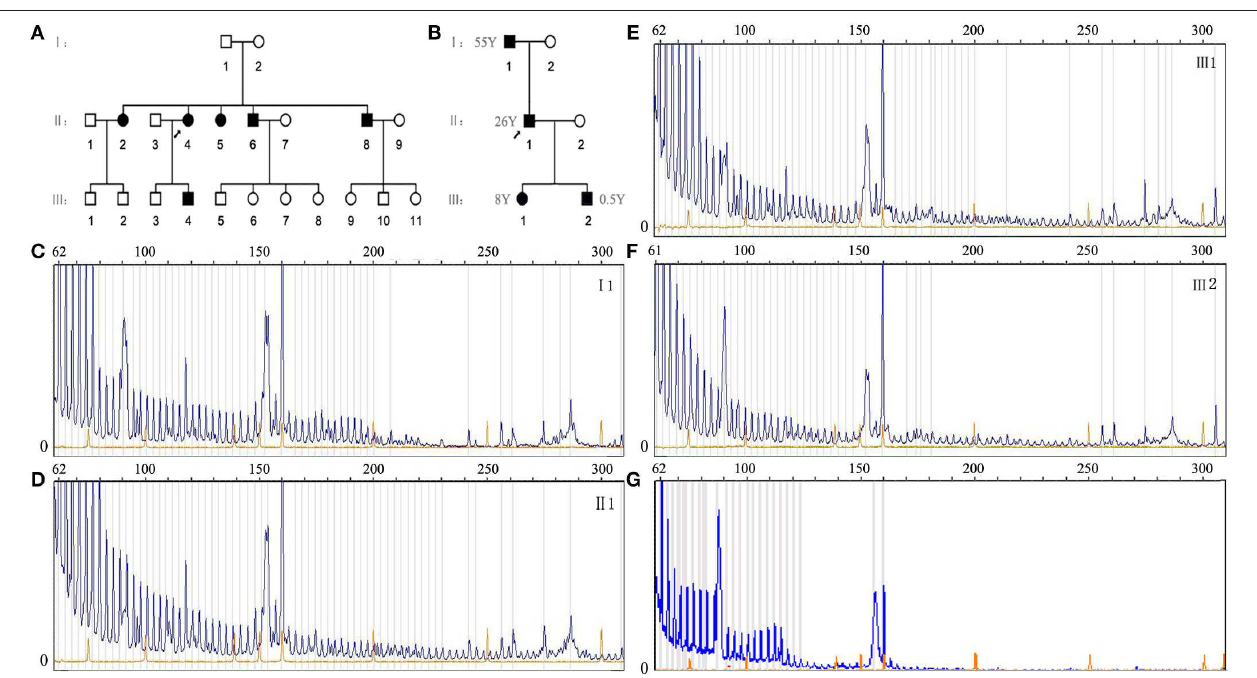
FIGURE 1 | (A) Family chart of the maternally transmitted pedigree (black arrow indicating the proband); (B) family chart of the paternal transmitted pedigree (black arrow indicating the proband); (C–G) electropherogram results of TP-PCR for affected members (I1, II1, III1, III2) in the paternal transmitted pedigree and an unaffected individual with two alleles < 30 repeats. X-axis illustrates the size in base pairs and Y-axis illustrates the allele peak height. The blue peaks, which start at the size of ∼ 62, indicate expanded alleles. Yellow peaks are sizing ladders, included as inner reference. Blue peaks forI1 fade away at the size of ∼ 216, showing the CTG repeat number is ∼ 50. Blue peaks for II1, III1, and III2 all exceed the size of 305, showing the CTG repeat numbers are over 80. The large bands observed at ∼ 90, 150, and 160 bp are also observed in the unaffected individuals with two alleles < 30 repeats (G) , indicating bands at these positions are non-specific during PCR.